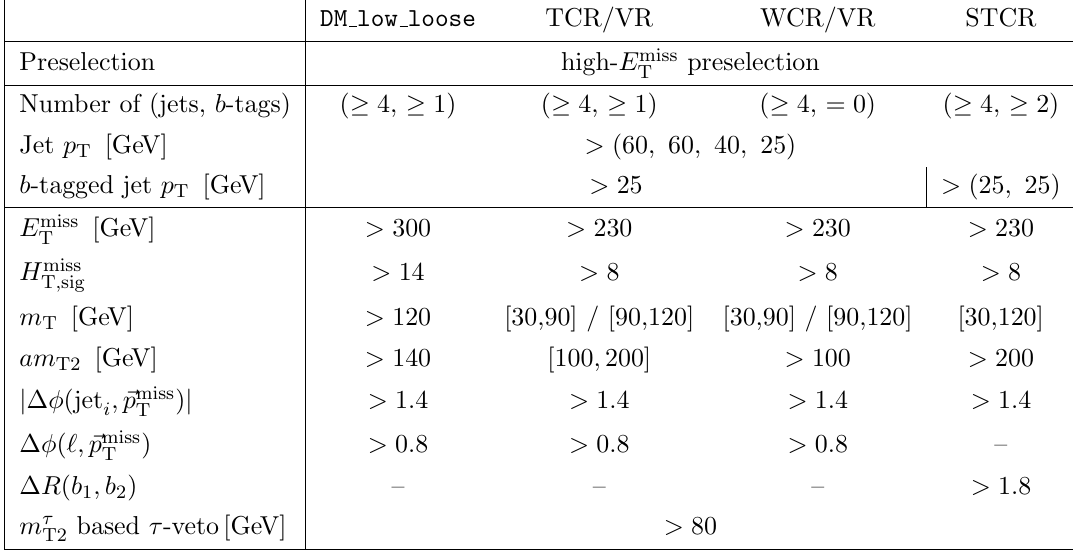
Table 15 . Overview of the selections for the DM low loose signal region as well as the associated control and validation regions. The control regions include the t (cid:22) t control region (TCR), the W +jets control region (WCR), and the single-top Wt control region (STCR). The validation regions include the t (cid:22) t validation region (TVR) and the W +jets validation region (WVR). List values are provided in between parentheses and square brackets denote intervals. The selection of the t (cid:22) t + V control region (TZCR) is detailed in section 8.6.